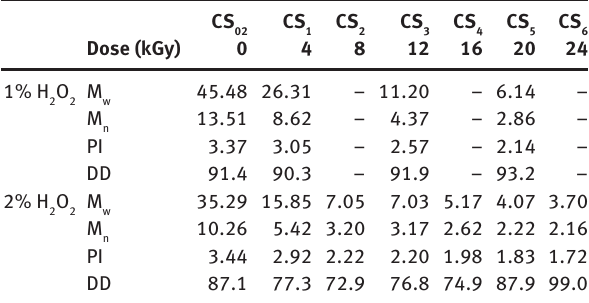
(kDa), M (kDa), PI, and DD (%) of chitosan samples w n O and γ -ray. 2 2